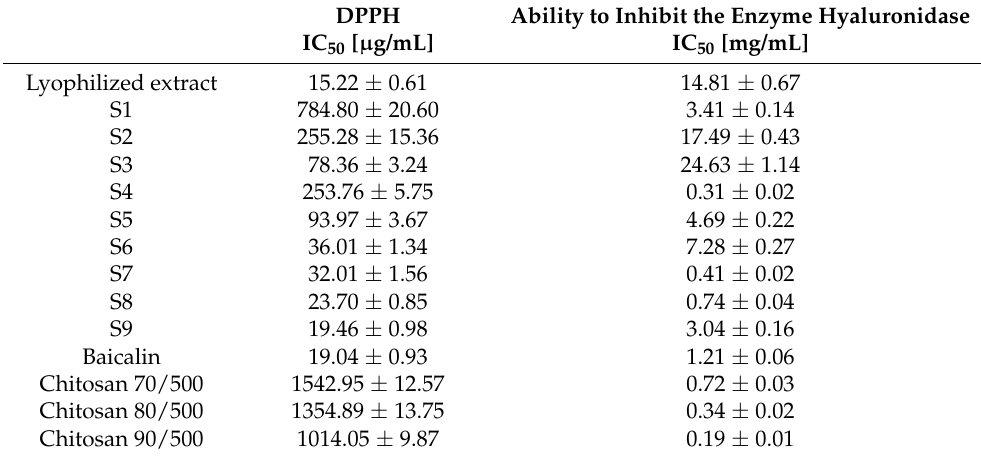
Table 5. Antioxidant and anti-hyaluronidase activities of chitosan systems.